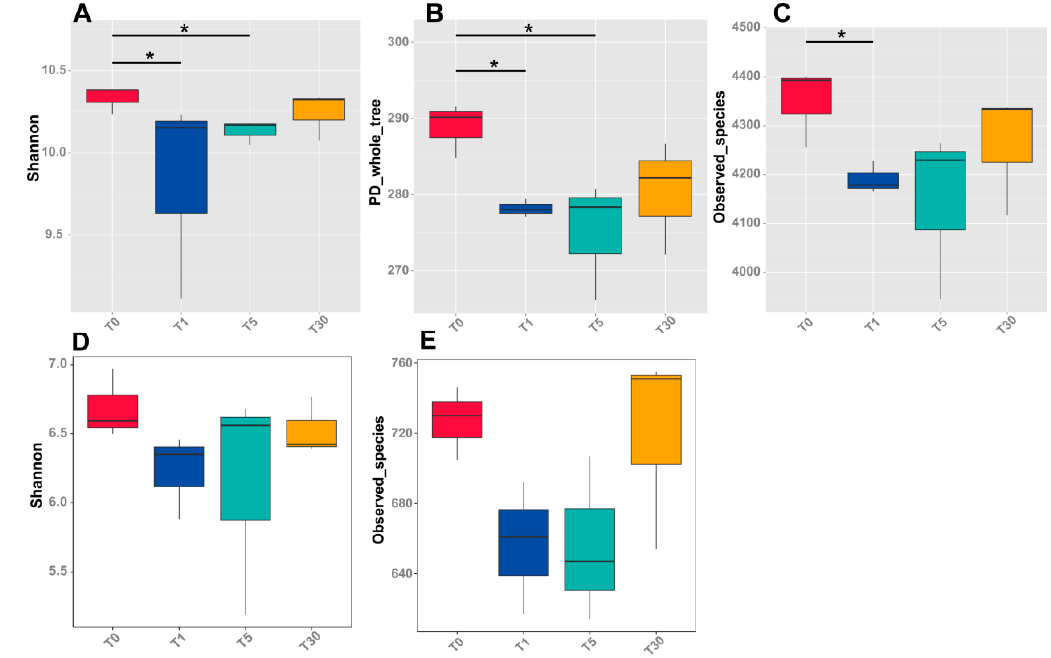
Figure 1. Alpha-diversity of the bacterial and fungal communities for four groups of microbial samples. ( A – C ), representing Shannon diversity, PD_whole tree, and observed species of the bacterial community, respectively; ( D , E ), representing Shannon diversity and observed species of the fungal community, respectively. Significances between di ff erent groups were compared using Wilcoxon’s test, with the results indicated on the top ( p -value ≤ 0.05 = *).